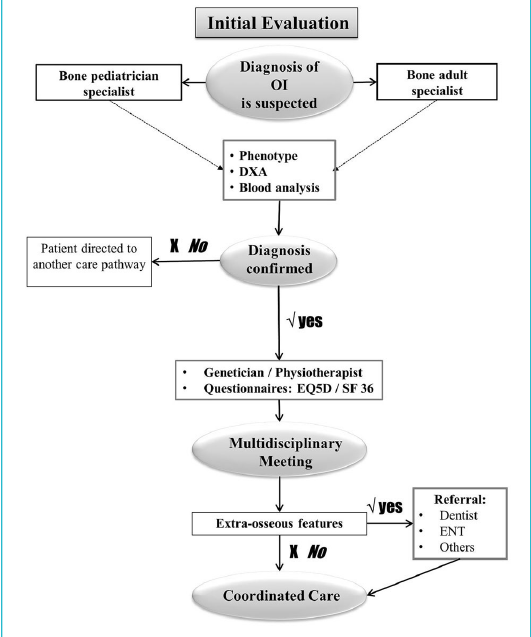
Figure 1: Initial evaluation pathway for OI patient in the CHUV OI group.; CHUV = Centre Hospitalier Universitaire Vaudois; DXA = dual X-ray absorptiometry; OI = osteogenesis